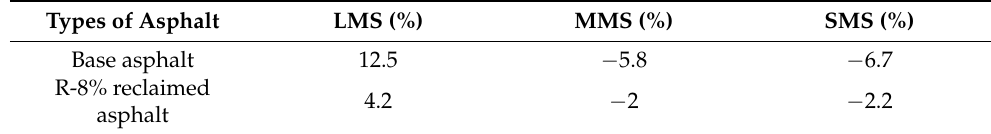
Table 6. Change range of molecular weight of asphalt after PAV aging. Types of Asphalt LMS (%) MMS (%) SMS (%) Base asphalt 12.5 − 5.8 − 6.7 R-8% reclaimed 4.2 − 2 − asphalt